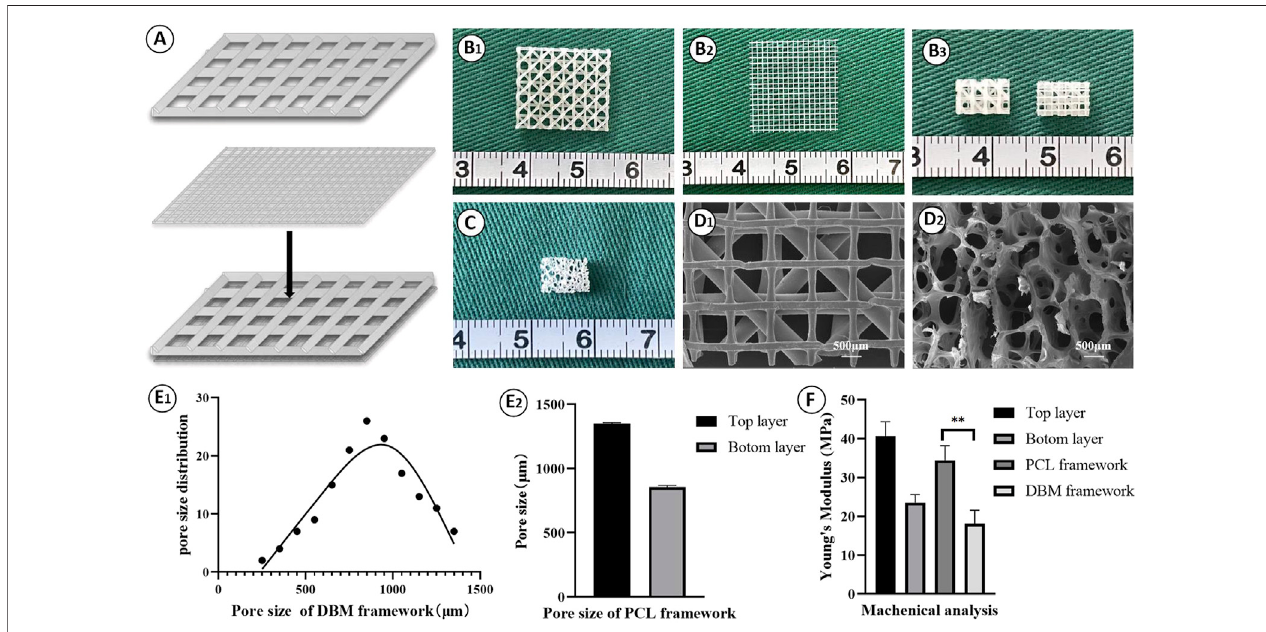
FIGURE1| FabricationandcharacterizationofPCLframework: (A) Thedesignofthe3D-printedPCLframework;Grossviewofthetoplayer (B1) ,thebottomlayer (B2) , and the front and the back views (B3) for the 3D-printed PCL frameworks; (C) Gross view of the DBM framework; SEM images of PCL framework (D1) and DBM framework (D2) ; Pore size of DBM framework (E1) and PCL framework (E2) ; (F) Young ’ s modulus of the frameworks. Statistical signi fi cance: pp p <